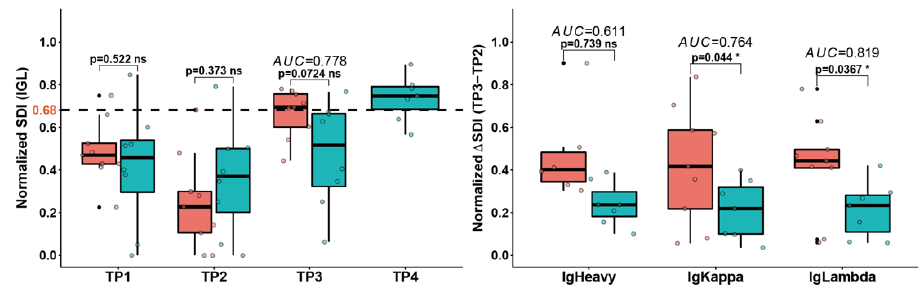
Figure 6. SDIs of peripheral BCR IR from DLBCL patients. The indices were normalized to the mean SDIs of healthy volunteers. T-test and ROC analysis between relapsed and non-relapse groups were carried out using R packages “rstatix” and “pROC”. Dashed horizontal lines marked the calculated cut-off levels (labeled in orange) for the corresponding diversity measures. Area under curve (AUC) values from the ROC analysis were labeled in italic.